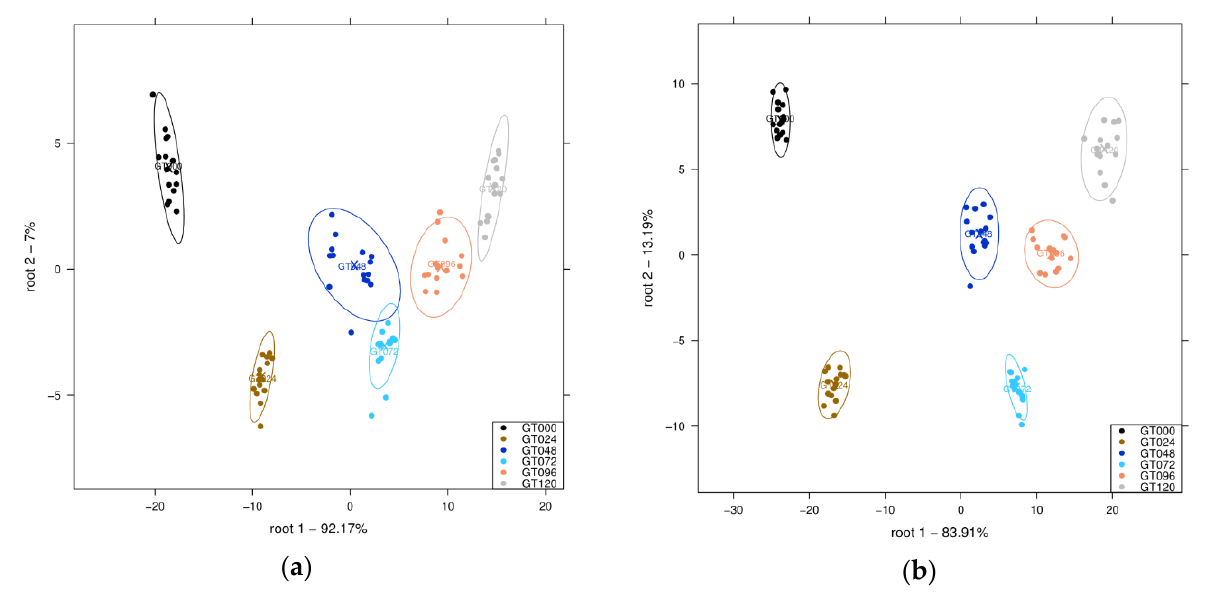
Figure 4. Linear discriminant analysis (LDA) on the spectral data of the mung bean sprout extract after Savitzky-Golay smoothing (SG) and standard normal variate (SNV) pretreatment, and three-fold cross-validation: ( a ) Score plot within 950–1630 nm wavelength interval, and ( b ) score plot within 1300–1600 nm first O-H overtone wavelength.